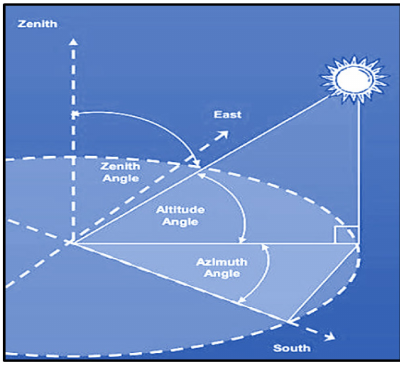
Figure 7. Azimuth, Altitude and zenith angles.